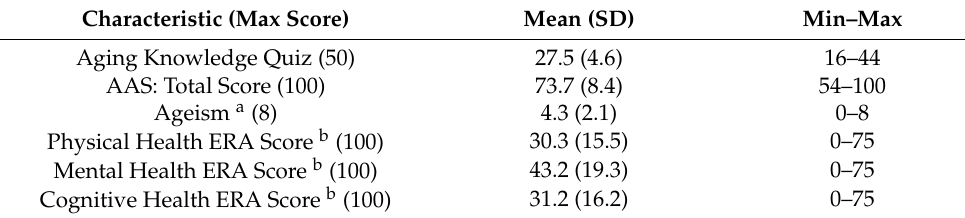
Table 2. Mean scores among health professionals on the measurement tools used in the study. Characteristic (Max